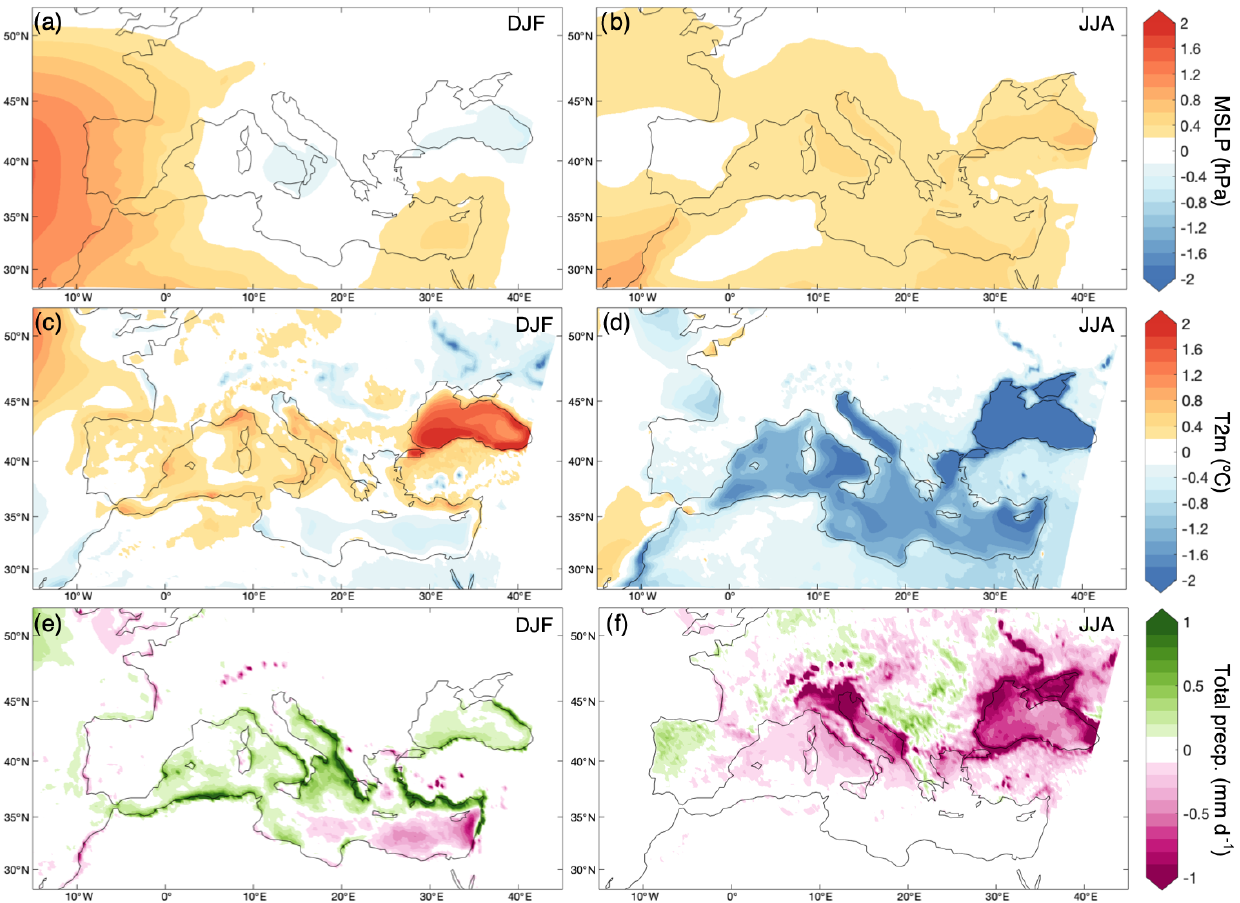
Figure 4. Differences between ROM_P0 and stand-alone REMO forced by ERA-Interim for the 1980–2012 period in mean sea level pressure (MSLP, hPa) (a, b) , near-surface (2m) temperature (T2m, ◦ C) (c, d) and precipitation (mmd − 1 ) (e, f) in winter (DJF a, c, e ) and summer (JJA b, d, f